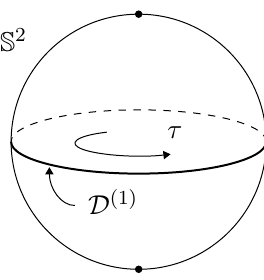
Figure 3 . The conformal defect D (1) on S d . For d = 2, it winds along the equator of S 2 ( (cid:28) -